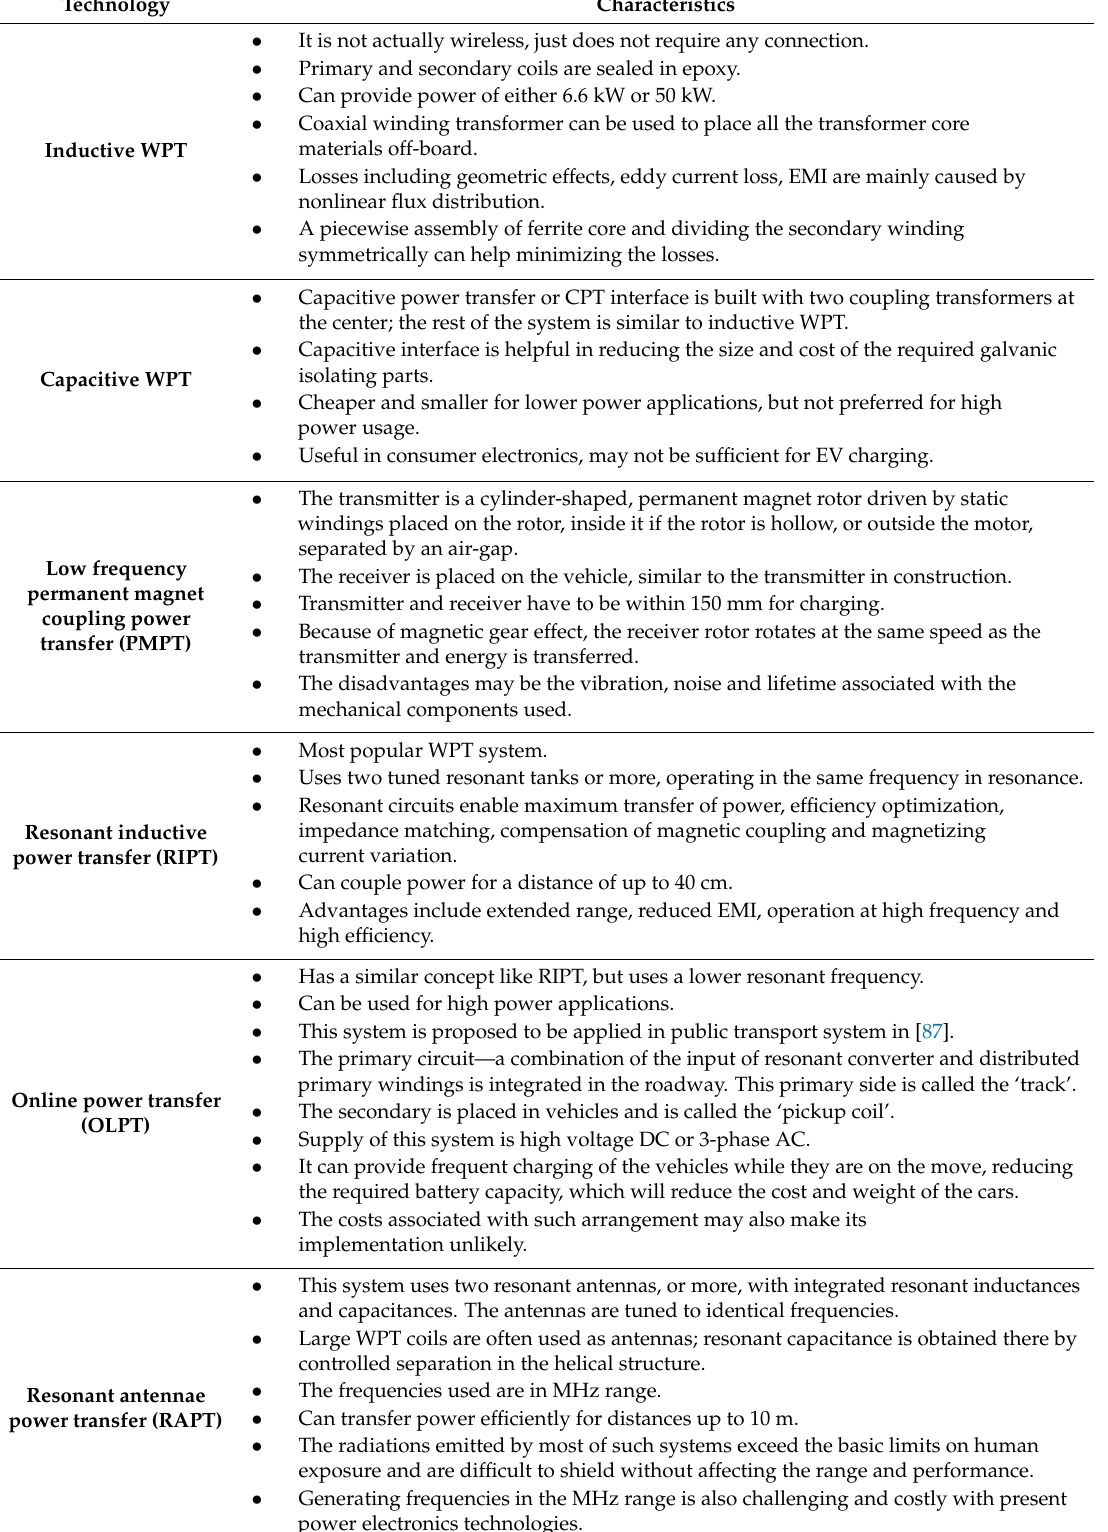
Table 25. Characteristics of wireless charging systems